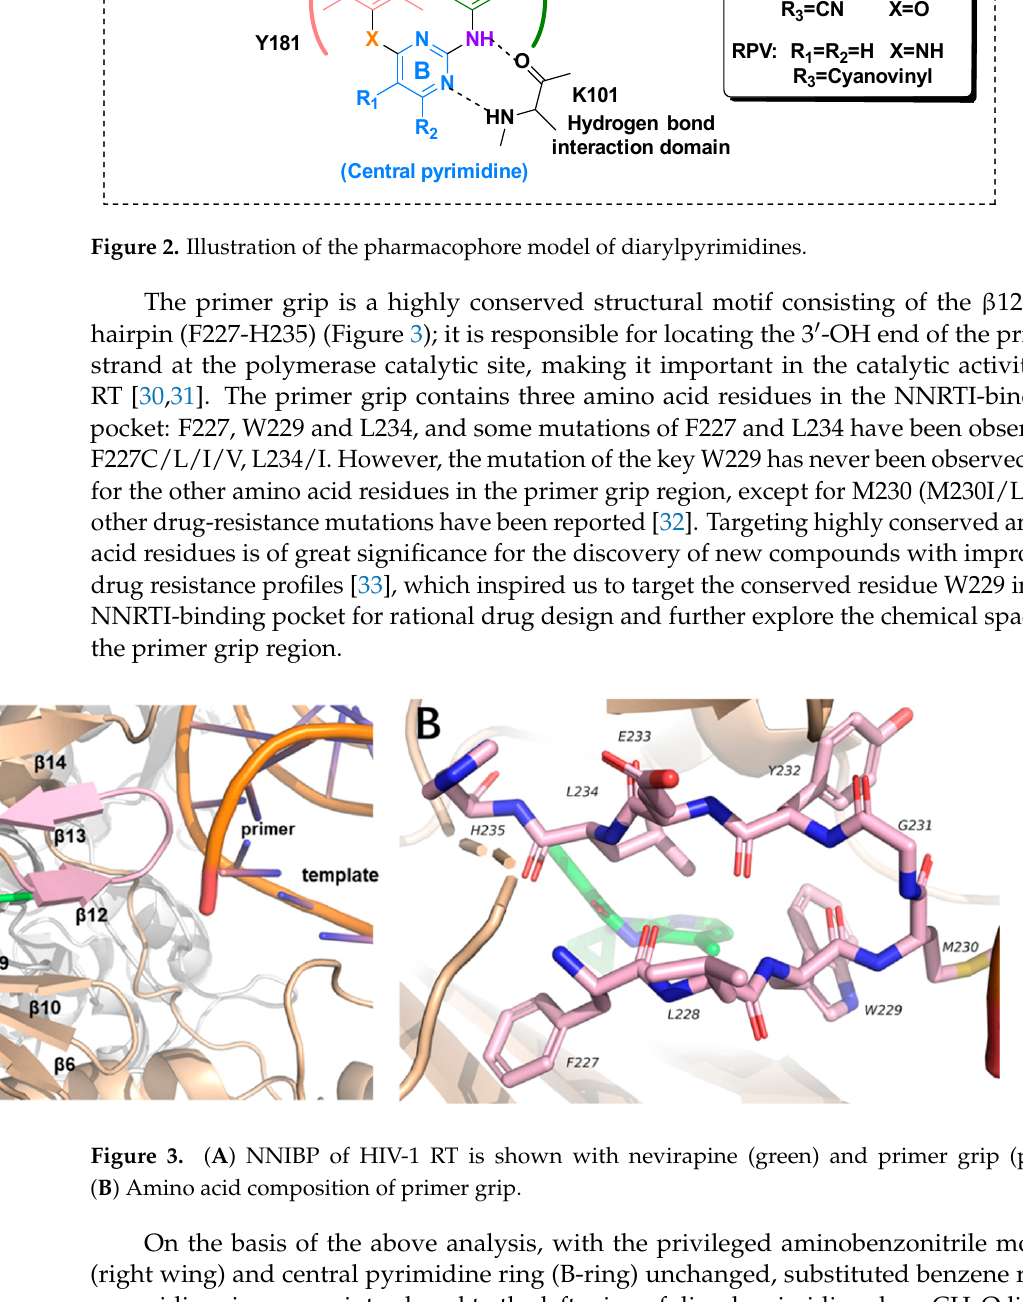
Figure 2. Illustration of the pharmacophore model of diarylpyrimidines .